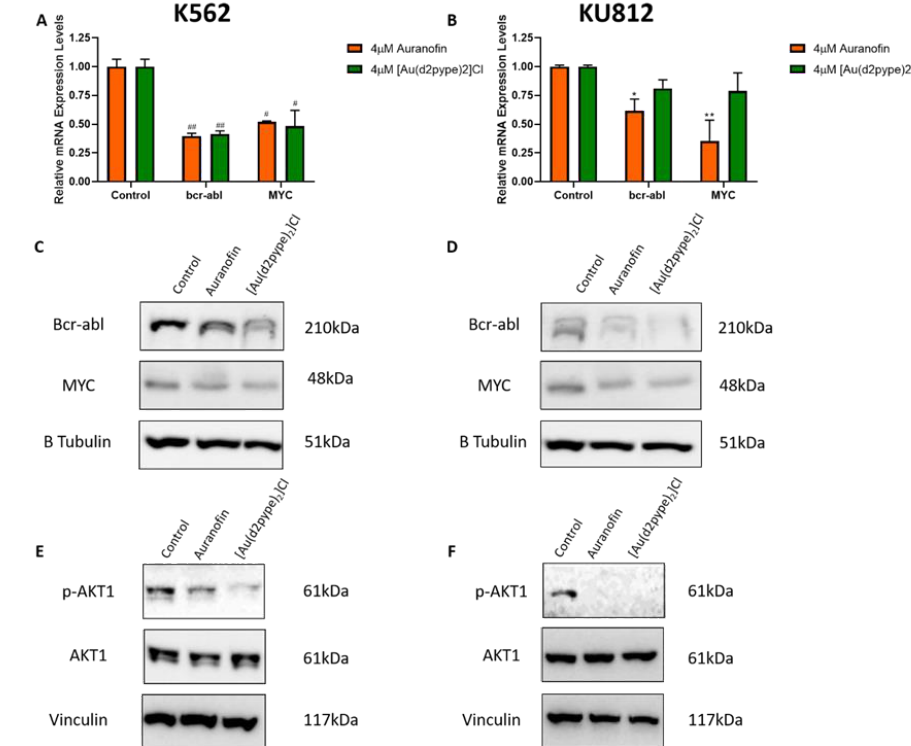
Figure 3. TrxR Inhibitors Reduce mRNA and Protein Expression of the Bcr-abl pathway. A,B : K562 and KU812 CML cells respectively were treated with 4 µM of either auranofin or [Au(d2pype) 2 ]Cl for 24 hrs. RT-qPCR was then used to measure the mRNA expression levels of bcr-abl and MYC. RPL32 was used as a normaliser C,D: K562 and KU812 CML cells respectively were treated with 4 µM of either auranofin or [Au(d2pype) 2 ]Cl for 24 hrs. Western blotting was then used to measure bcr-abl and MYC protein levels. E,F : K562 and KU812 CML cells respectively were treated with either 4µM of auranofin or 8 µM [Au(d2pype) 2 ]Cl in the K562 cells and 4 µM of the inhibitors in the KU812 cells for 24 hrs. Western blotting was then used to measure p-AKT1 and AKT1 levels. Vinculin and Β-tubulin was used as loading controls for western blots. RT-qPCR results were analysed with multiple T-tests. Statistical tests compared results of the treated and untreated cells. * = p < 0.05, **= p < 0.01, # = p < 0.001, ## = p < 0.0001. N = 3. Values displayed as mean ± SEM.